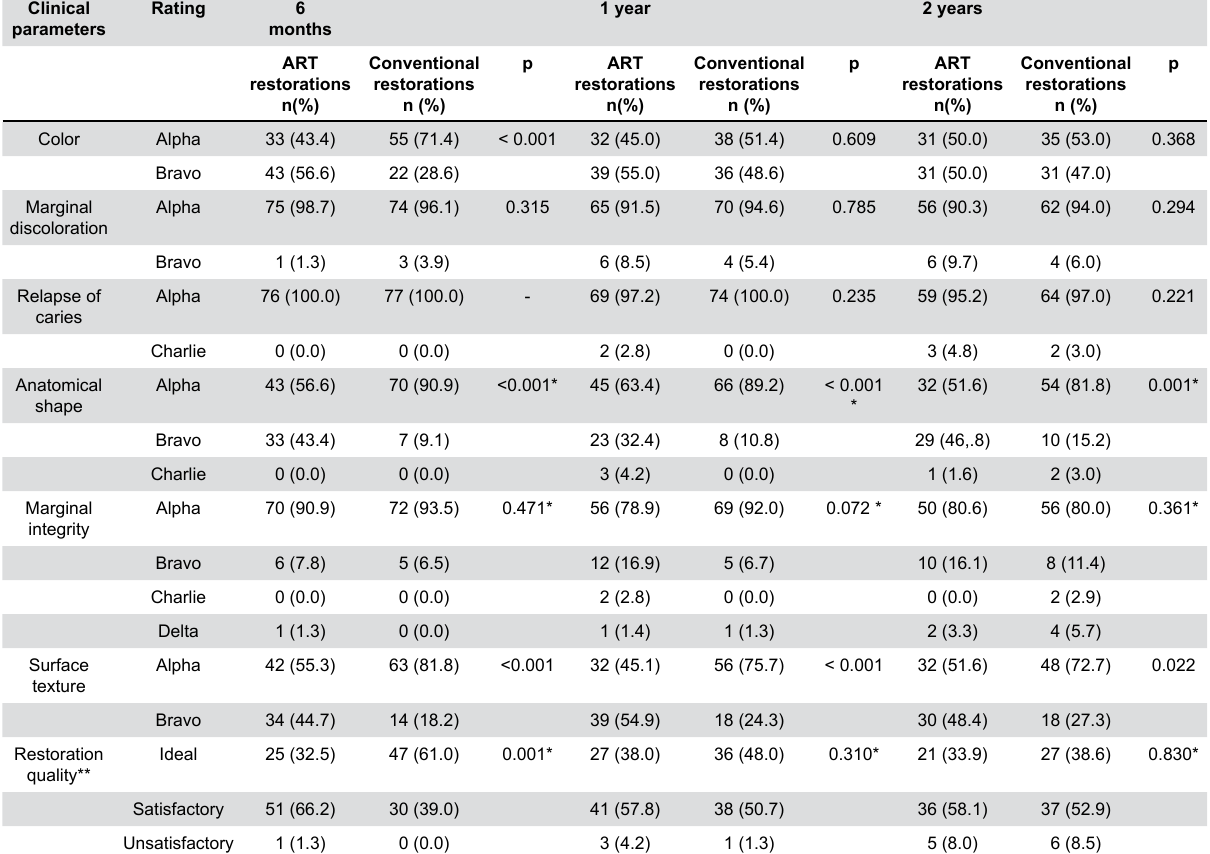
Table 2- Distribution of scores according to the modified USPHS criterion for ART restorations with HVGIC and conventional restorations with resin composite